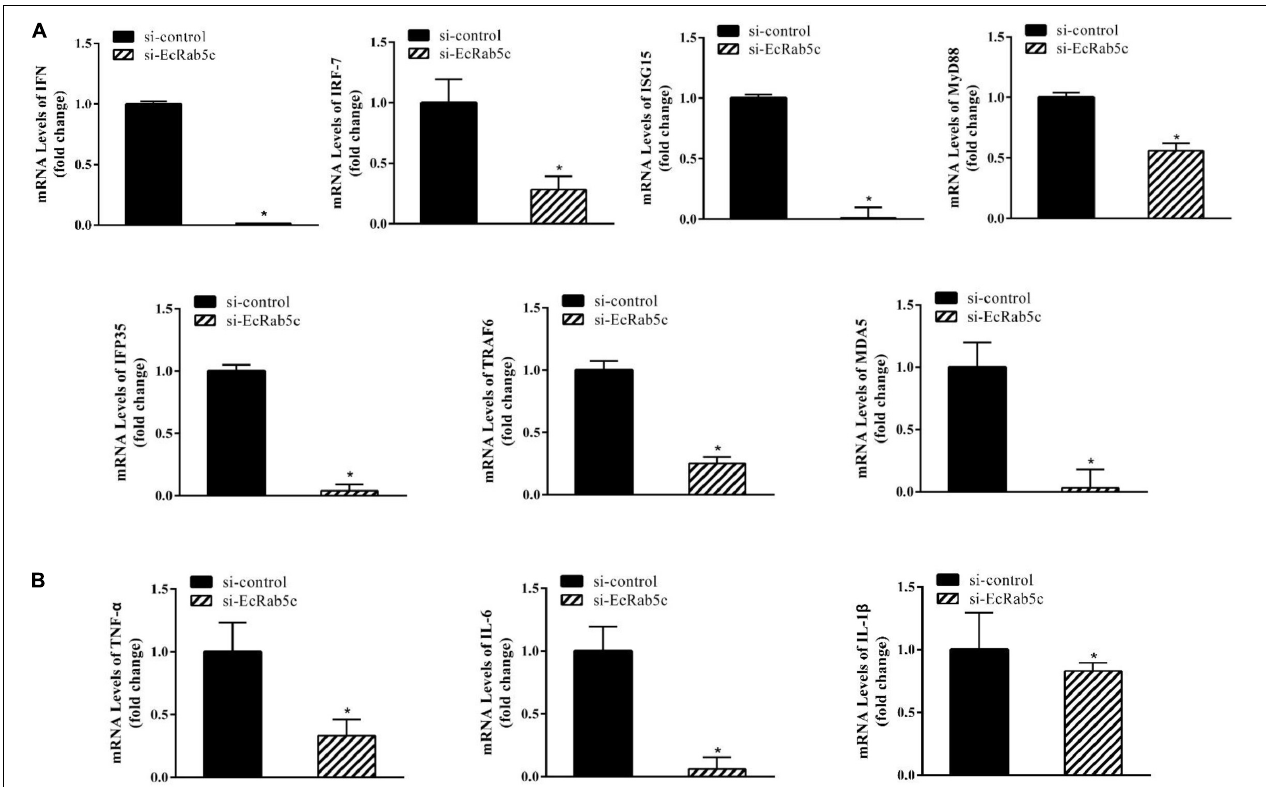
FIGURE 8 | Knockdown of EcRab5c inhibited IFN-signaling molecules (A) including IFN, IRF-7, ISG15, MyD88, IFP35, TRAF6, MDA5, and pro-inflammatory cytokines (B) including TNF- α , IL-6, and IL-1 β . GS cells were transfected with si-control or si-EcRab5c. After 36 h, the cells were collected for qRT-PCR ( n = 3, mean ± SEM). * p <